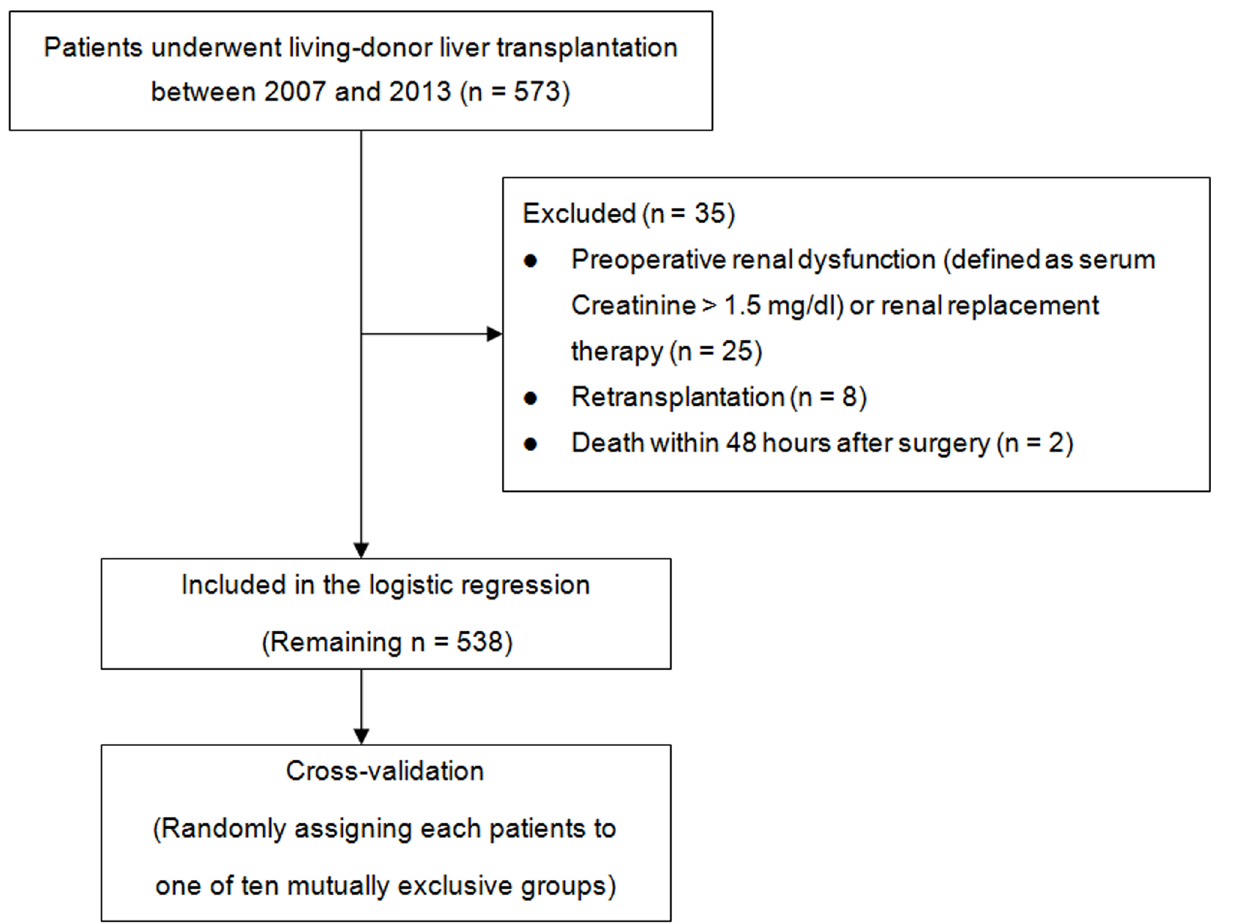
Fig 1. Flow diagram outlining the inclusion and exclusion criteria and study